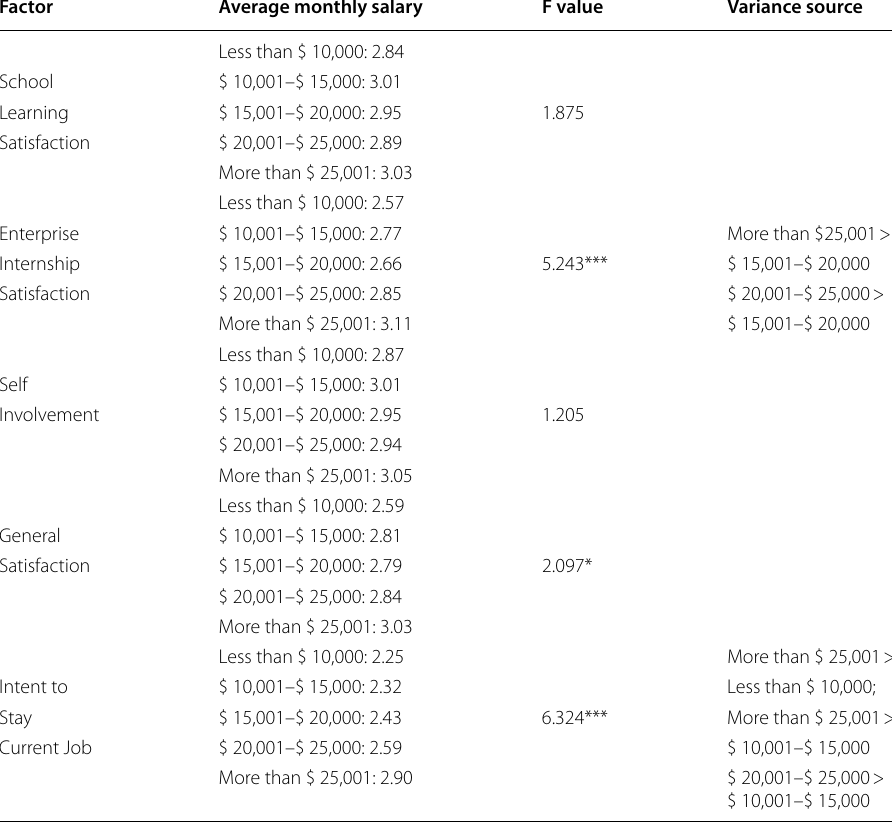
Table 2 Analysis of variance on average monthly